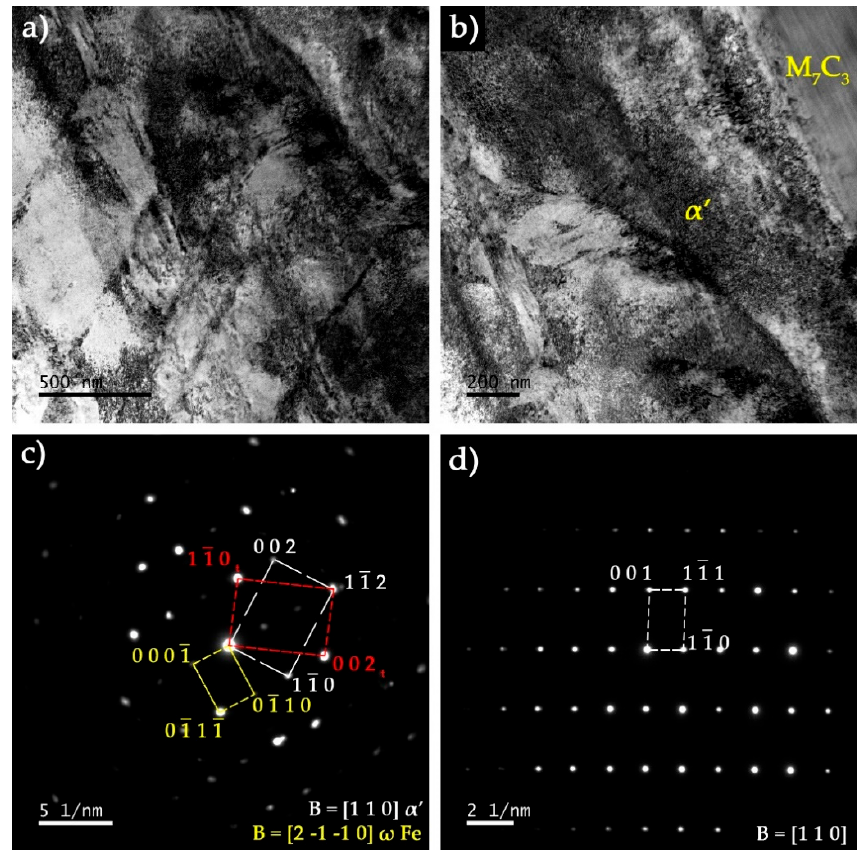
Figure 11. Dark-field TEM image of the base metal showing ( a ) α ’ phase revealing twin contrast and ( b ) interface between α ’ and a Cr-rich M 7 C 3 carbide. The identification of phases was concluded by selected area electron diffraction (SAED) analysis with ( c ) [110] zone axis of α ’ and ( d ) [110] zone axis of M 7 C 3 .